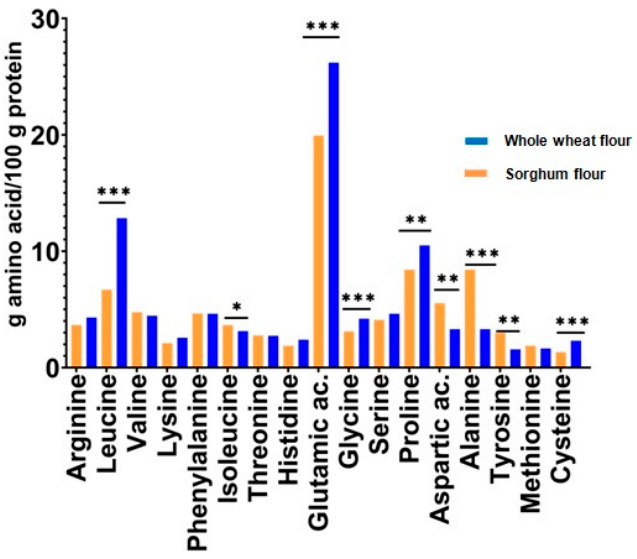
Figure 2. Chemical scores of amino acids of sorghum and whole wheat seeds. Note: *, **, *** Correlations significant at p < 0.05, p < 0.01, and p < 0.001, respectively.